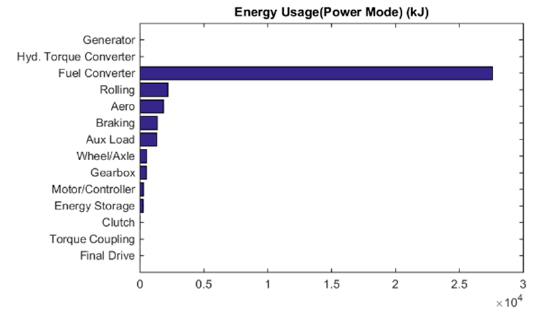
Figure 12. Energy use power mode.